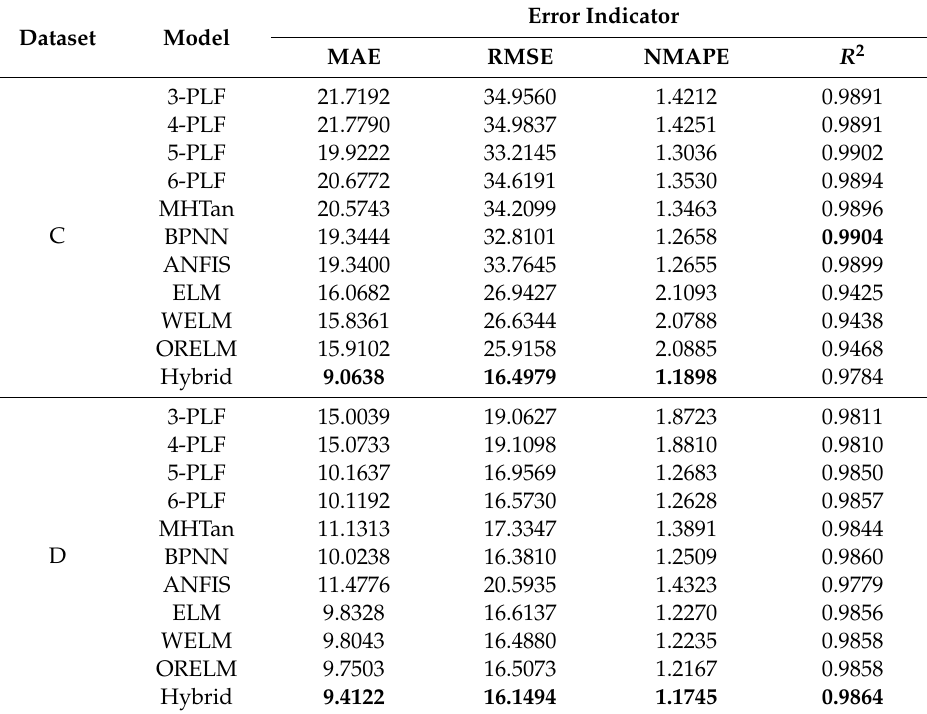
Table 9. Results of all power curve models on test sets of Dataset C and Dataset